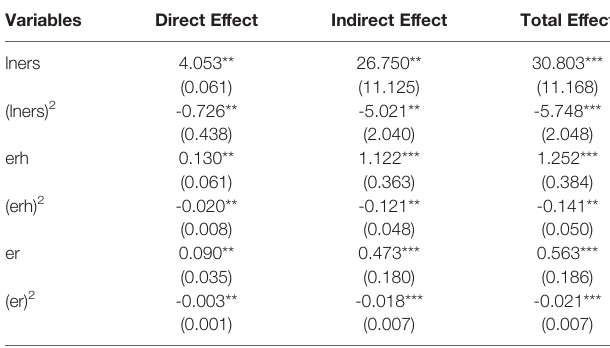
TABLE 8 | Regression results of spatial dobbin